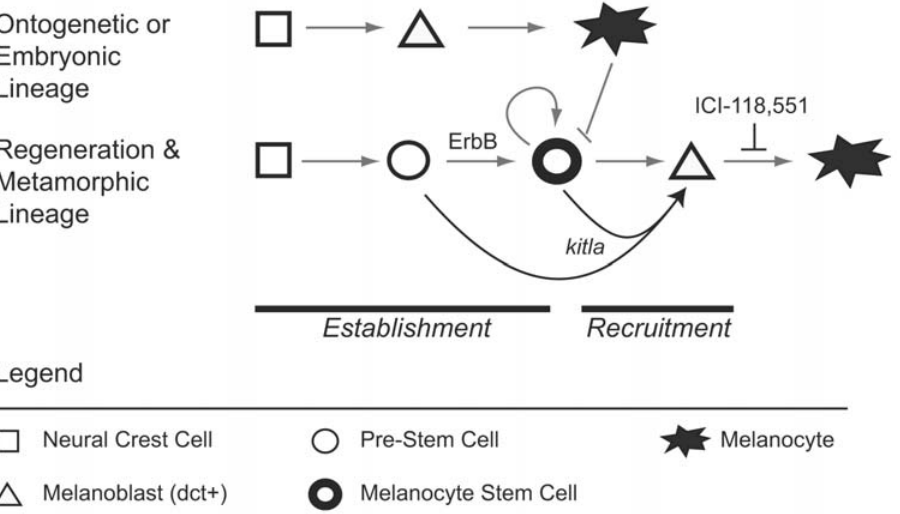
Figure 8. Model for the parallel establishment of the zebrafish embryonic melanocyte lineage and the adult melanocyte stem cell lineage. Our results indicate that there are two distinct melanocyte lineages that develop in the zebrafish embryo: the embryonic or ontogenetic melanocyte lineage and the regenerative and metamorphic melanocyte lineage. In embryonic development, neural crest cells (squares) give rise to dct + melanoblasts (triangles), which later develop into embryonic melanocytes (black star). The regeneration and metamorphic lineage develops in parallel to embryonic melanocytes, prior to 48 hpf and presumably from the neural crest. The establishment of melanocyte stem cells (MSCs, dark circle) require ErbB signaling to progress from the pre-MSC state (light circle). The MSC can self-renew (circular arrow) and give rise to melanoblasts and melanocytes during metamorphosis or regeneration, when inhibition from embryonic melanocytes (block arrow) is relieved. The MSC–derived melanocytes are sensitive to developmental blockade by ICI-118,551 after the dct + melanoblast stage. Ectopic expression of kitla can recruit the MSC lineage by either inducing MSCs or pre–MSCs resulting in overproliferation of melanocytes.